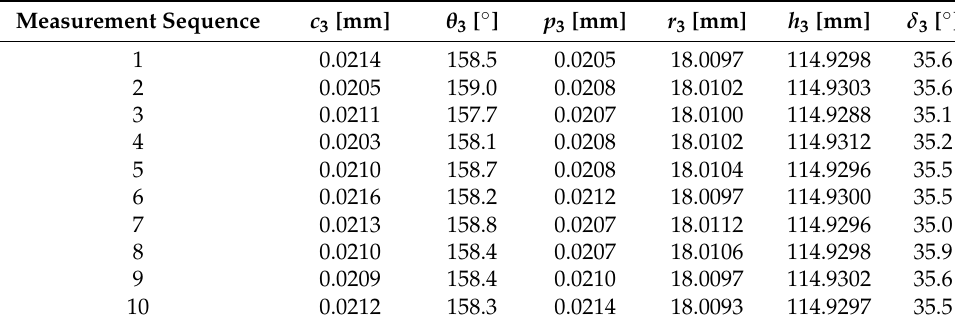
Table A3. The measured geometric parameters of the